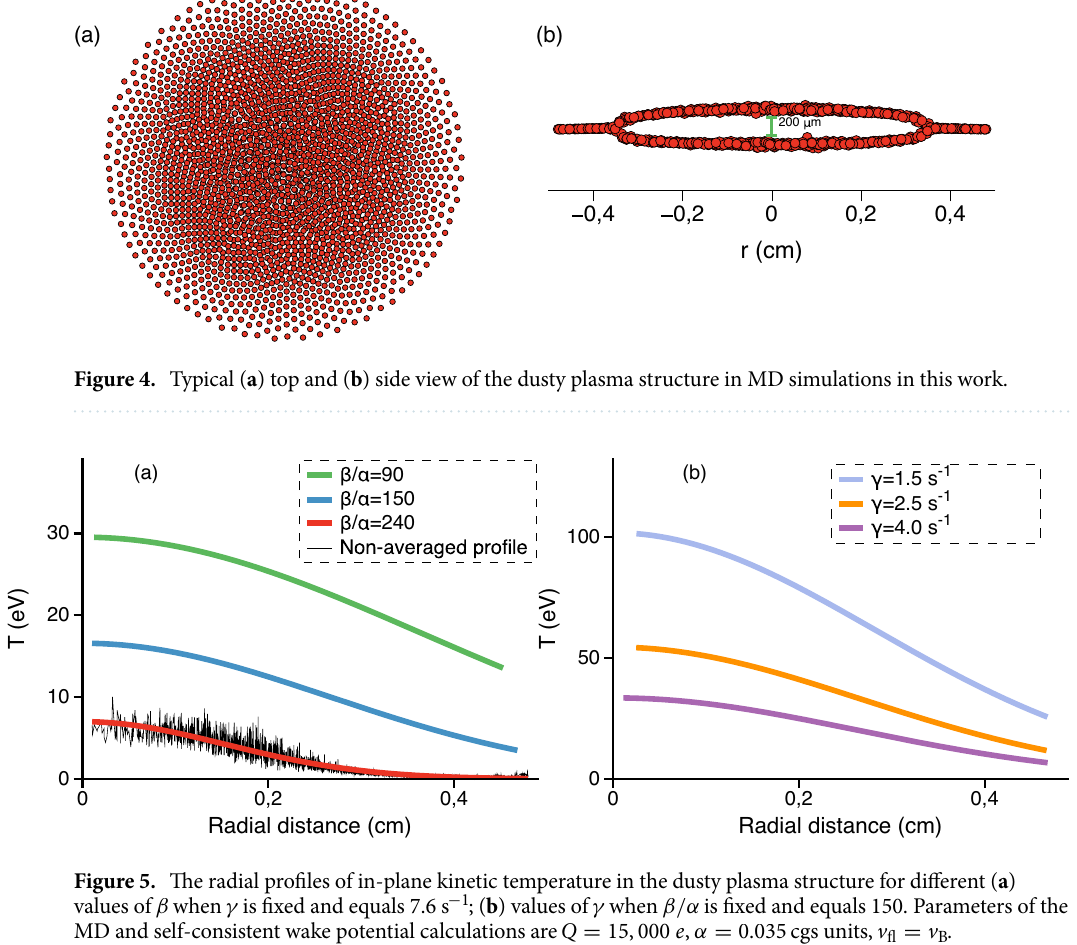
v B 15, 000 e , α 0.035 cgs units, v fl = = =